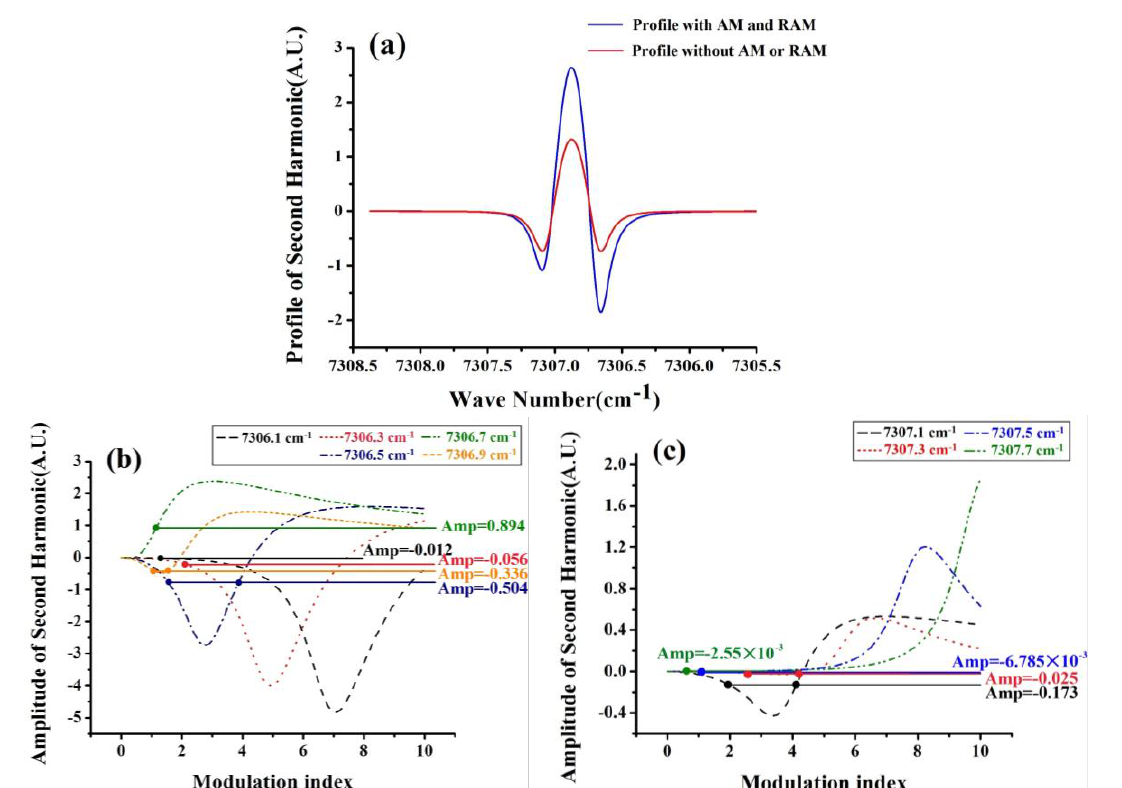
Figure 1. Amplitude of the second harmonic with amplitude modulation (AM) and residual amplitude modulation (RAM) is greater than that without AM or RAM in ( a ), so we can learn that the profile with AM and RAM can be adjusted to the profile without AM or RAM. Relationships between the amplitude of the second harmonic and the modulation index m are given in ( b , c ) by solid lines, so we can learn that not only can the profile be adjusted, the value of the modulation index for the adjustment can be